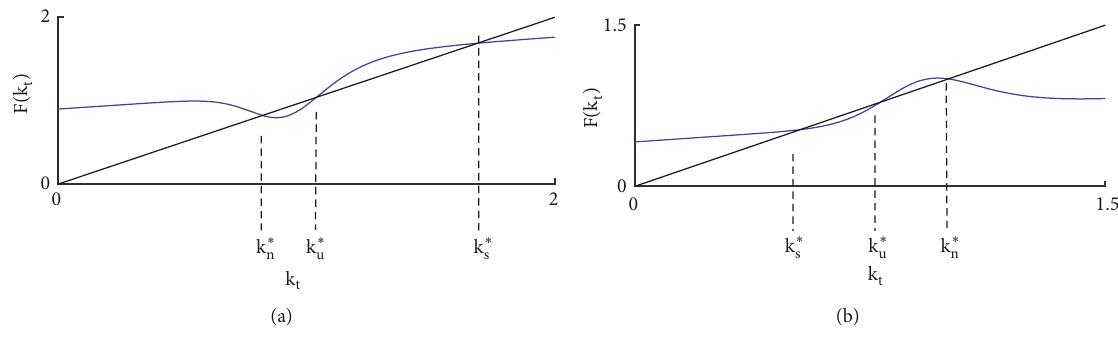
Figure 3: Parameter values 𝑛 = 1.72 , 𝛿 = .46 , 𝑠 𝑟 = .44 , 𝛼 = 2.65 , 𝛽 = 1.73 , and 𝜌 = 8.82 . (a) 𝑘 ∗ 𝑛 < 𝑘 ∗ 𝑢 < 𝑘 ∗ 𝑠 for 𝑠 𝑤 = .83 and 𝑐 = 2.95 , (b) 𝑘 ∗ 𝑠 < 𝑘 ∗ 𝑢 < 𝑘 ∗ 𝑛 for 𝑠 𝑤 = .15 and 𝑐 = 7.5 .